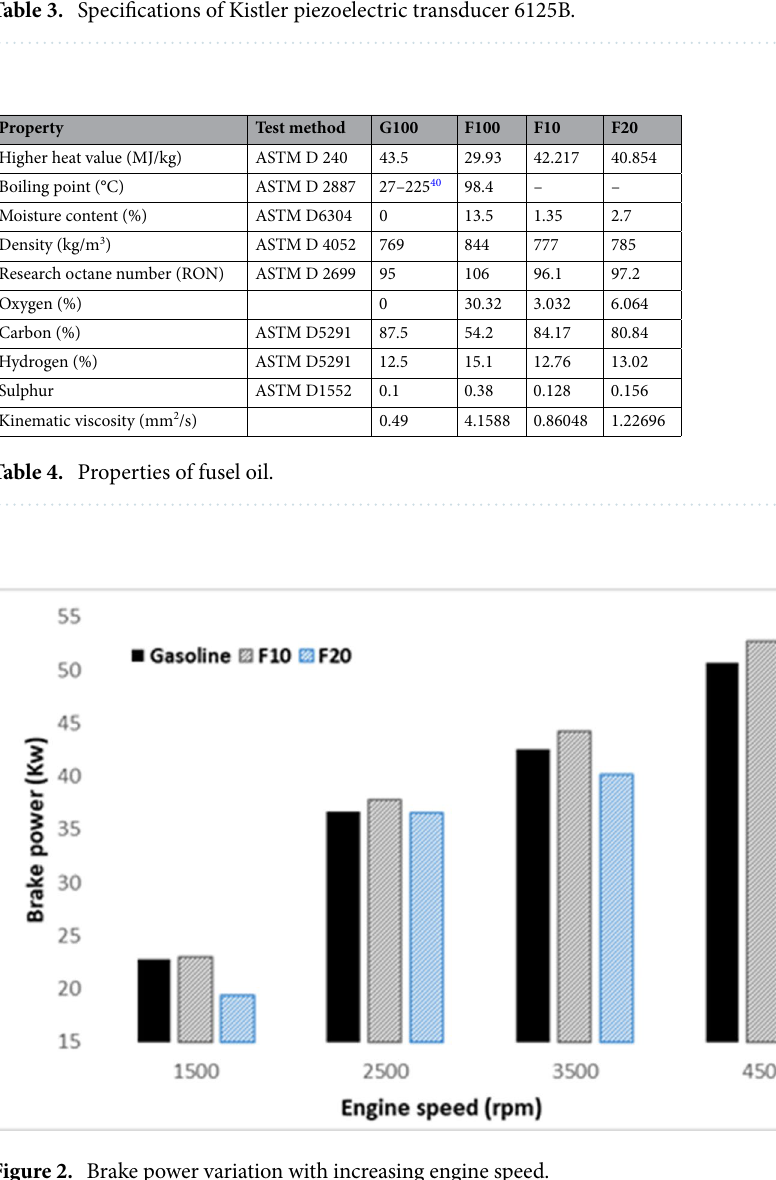
Figure 2. Brake power variation with increasing engine